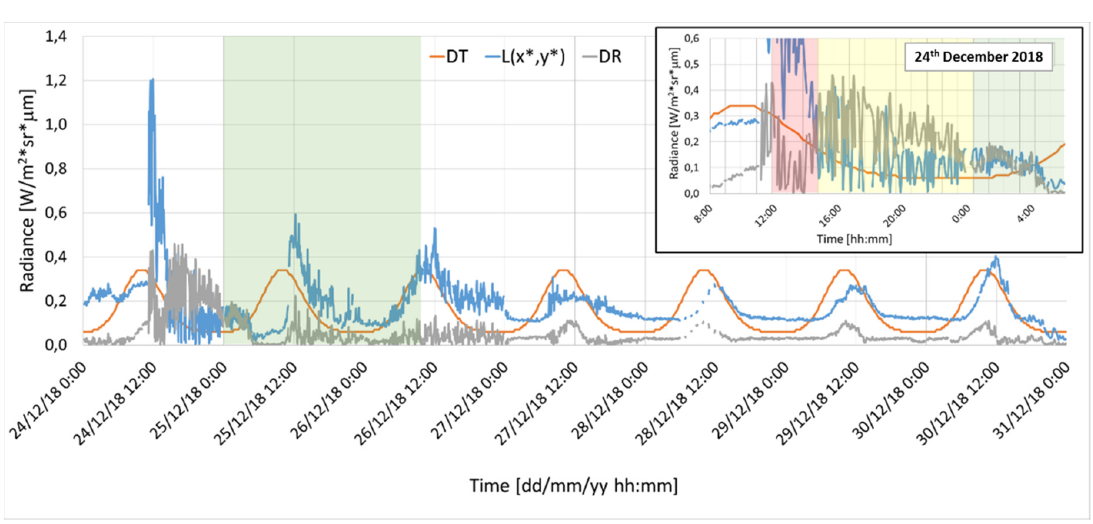
Figure 2. RGB composite (R: T b,8.7 –T b,10.8 ; G: T b,12 –T b,10.8 ; B: T b,10.8 ) showing the Etna volcanic cloud detection considering several Spinning Enhanced Visible and InfraRed Imager (SEVIRI) images collected from 24 to 30 December 2018. The prevalence of red and green colors identify ash and SO 2 , respectively.